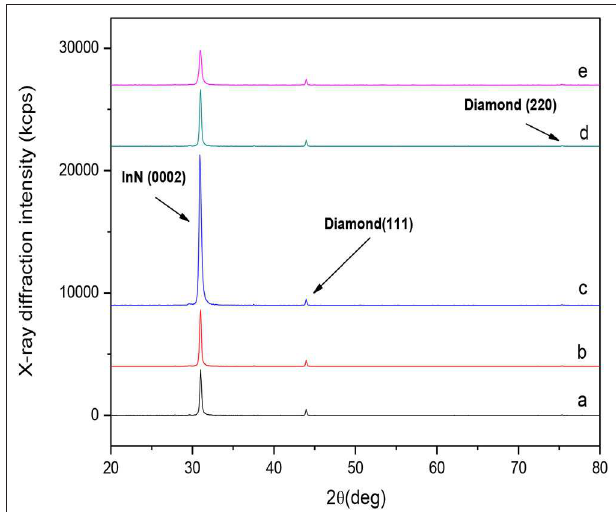
FIGURE 2 | The XRD patterns of InN (0002) plane films at various N 2 flux for (a) 60 sccm, (b) 70 sccm, (c) 80 sccm, (d) 90 sccm, and (e) 100 sccm, respectively.